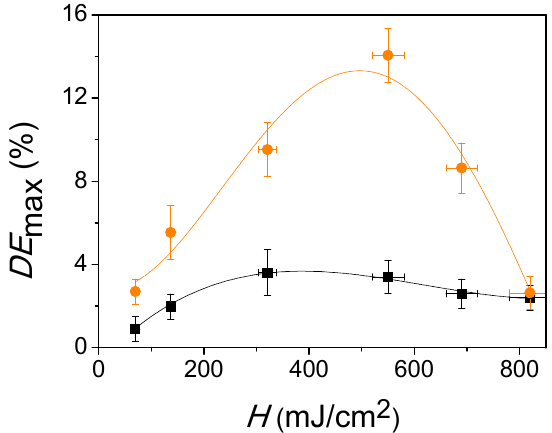
Figure 4. Normalized maximum diffraction efficiencies ( DE max ) vs radiant exposure ( H ) for recording (black squares) and curing (orange circles) stages. The lines represent the experimental data polynomial fit.